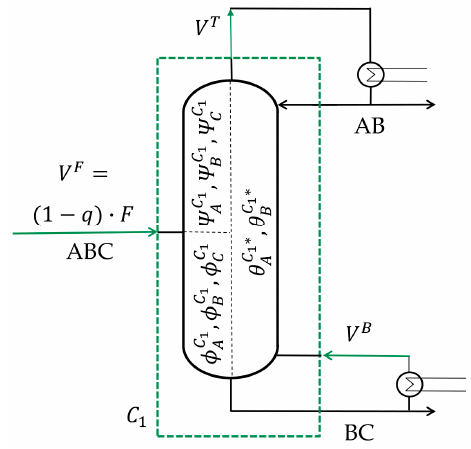
Figure 4. Vapor balance around a column C 1 for the separation of a three component mixture ABC.